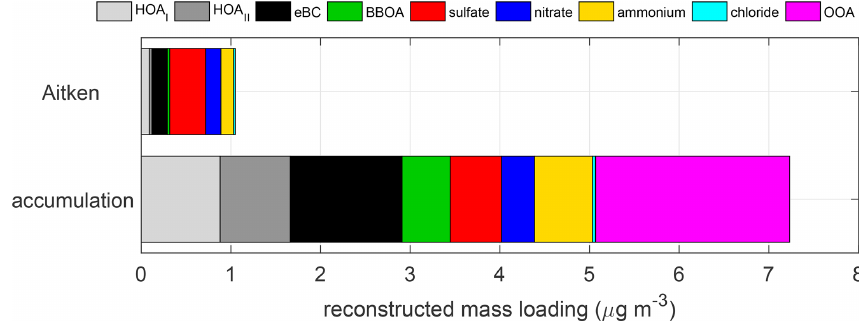
Figure 8. Reconstructed mass loading into Aitken and accumulation modes, as attributed by the MLR